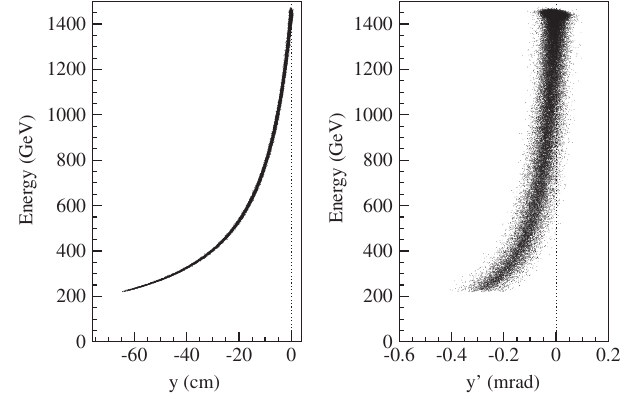
FIG. 15. y and y 0 distributions as a function of the energy for the disrupted beam, after the post-collision